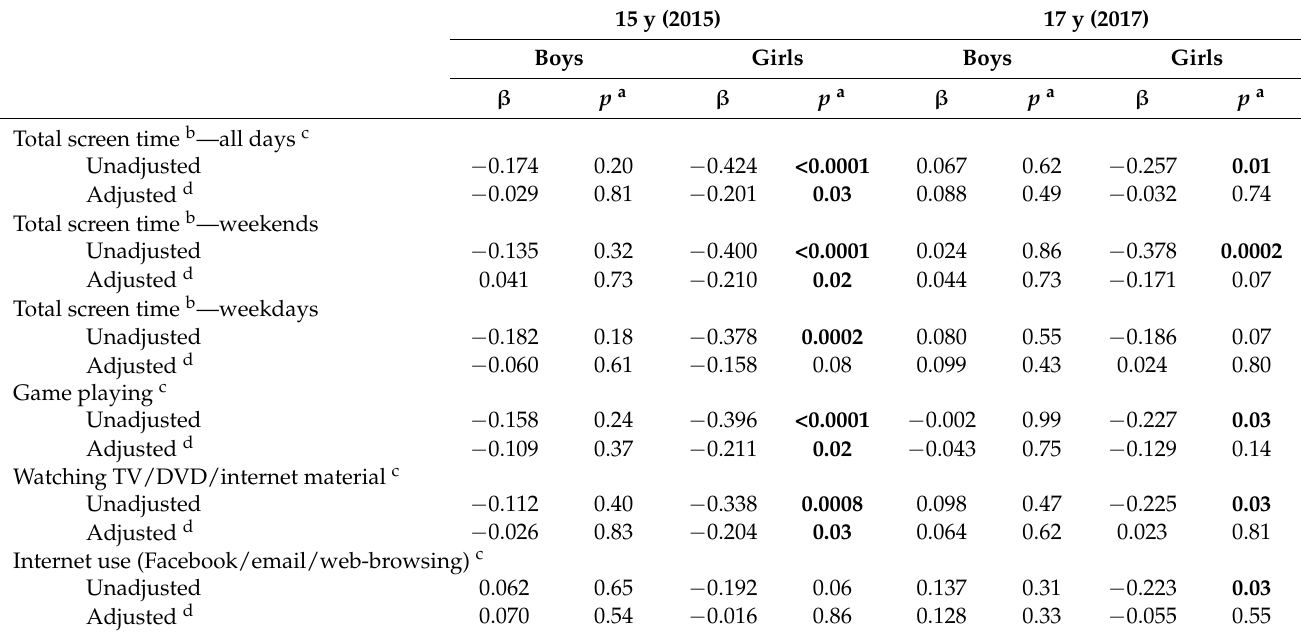
Table 3. Linear relationships between hours of average daily screen time and body image score.